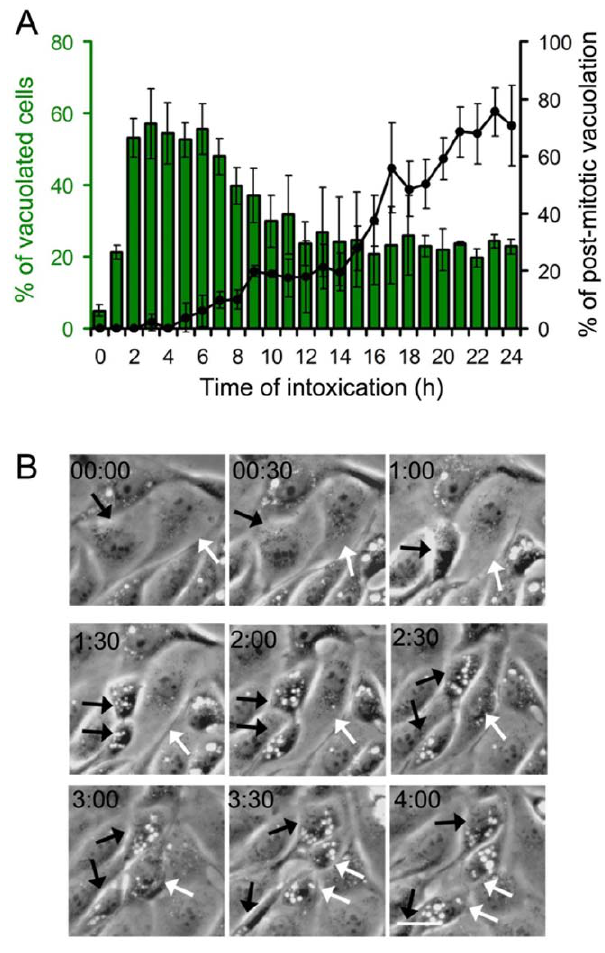
Figure 3. Dynamics of Bin-induced vacuolation. (A) Bin-treated (for 24 h) subconfluent MDCK-Cpm1 cells were submitted to time-lapse phase contrast video microscopy, as exemplified in video S1. At the indicated period of time the percentage of MDCK-Cpm1 cells displaying at least one vacuole was determined. Mean values 6 SD, n = 3. In the same videos, the percentage of cells that present post-mitotic vacuolation among the cells that display at least one vacuole, as illustrated in (B) was determined. Mean values 6 SD, n = 3. (B) Bin- treated cells displaying the post-mitotic vacuolation phenomenon; images selected from video S2. The selection starts 15h after intoxication, intervals in hours. Black and white arrows pinpoint two dividing cells. Bars, 10 m